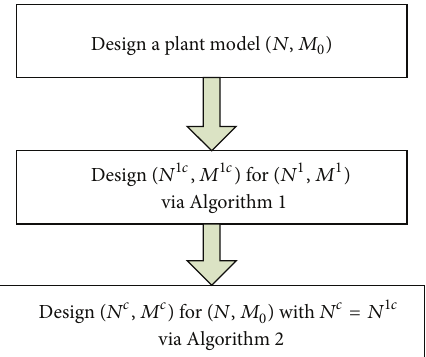
Figure 3: Flowchart of the deadlock prevention